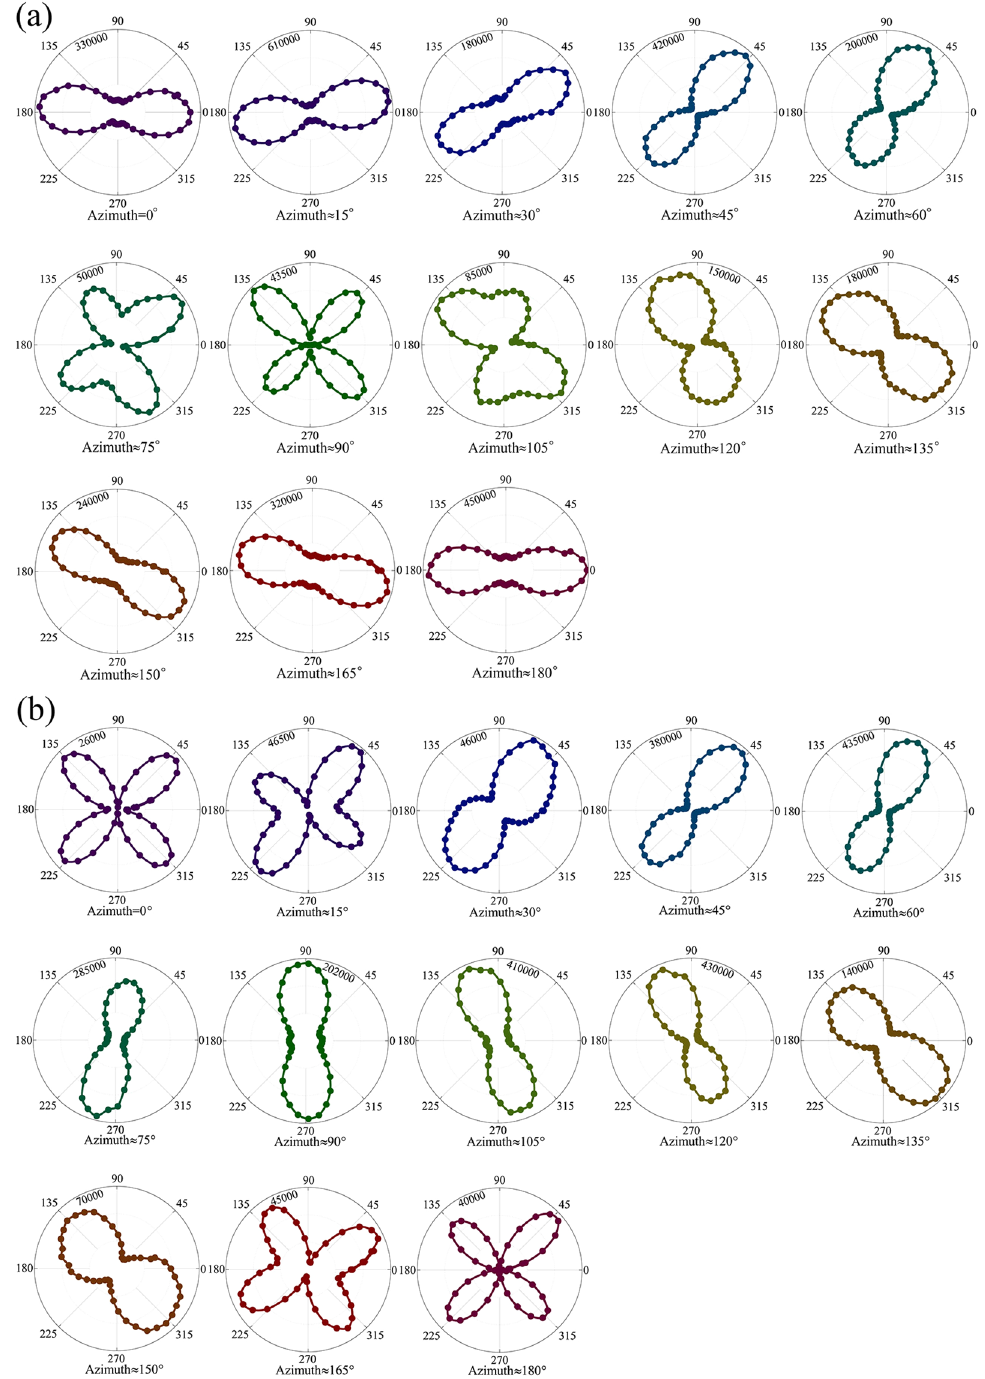
Figure 2. SHG anisotropy patterns in different azimuth angles under ( a ) perpendicular and ( b ) parallel configurations. The colored circles are experimental data, and they are linked to explicitly show the shapes of the SHG